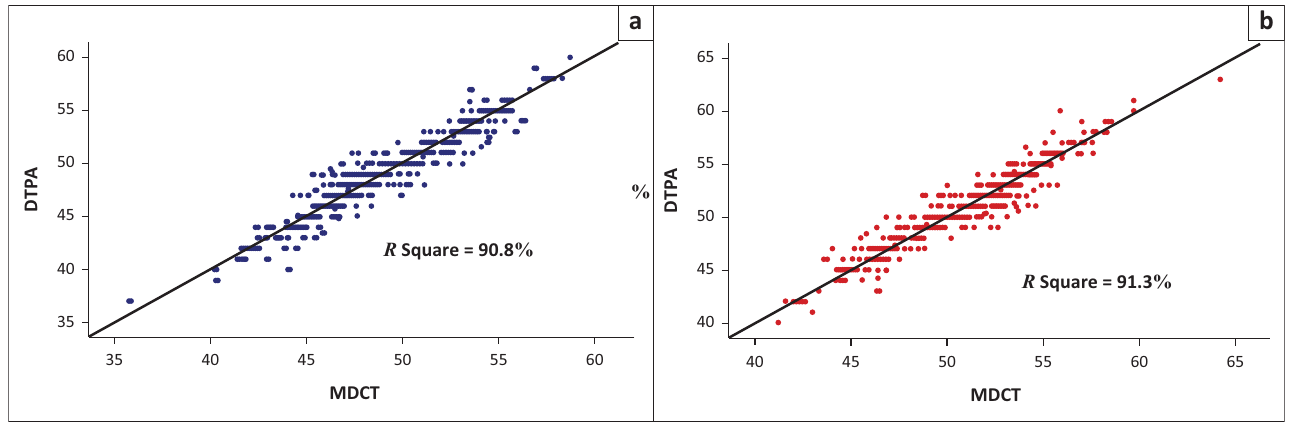
FIGURE 5 : Scatter diagram showing multidetector computed tomography prediction of the diethylenetriaminepentaacetic acid split renal function (outcome) by linear regression analysis for (a) the left kidney and (b) the right